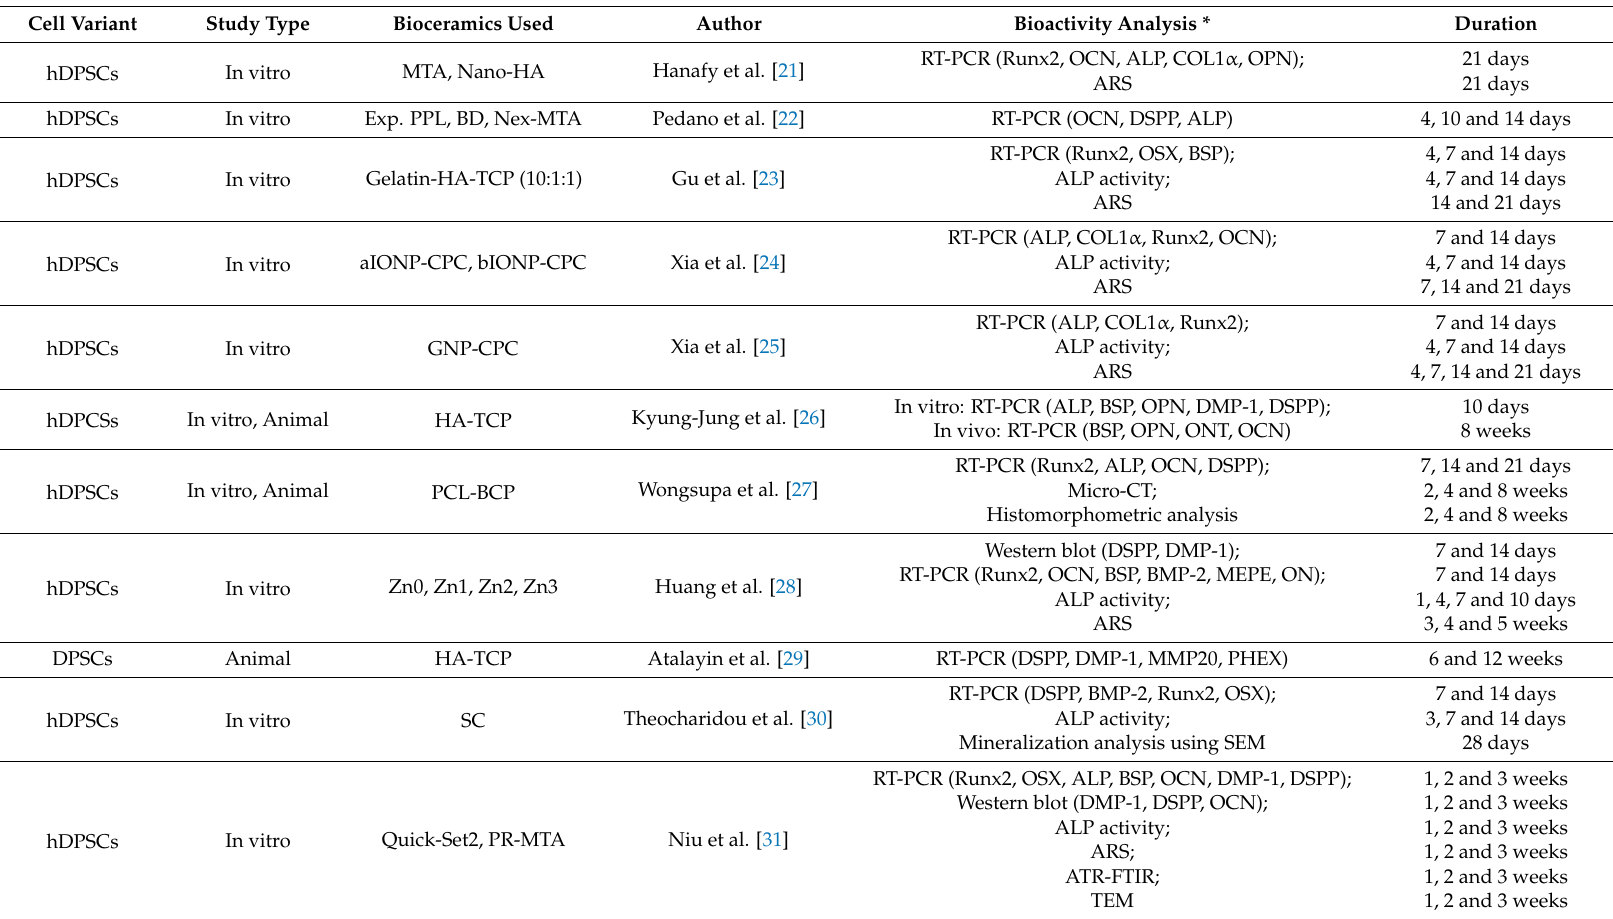
Table 1. Summary of the methodology of included